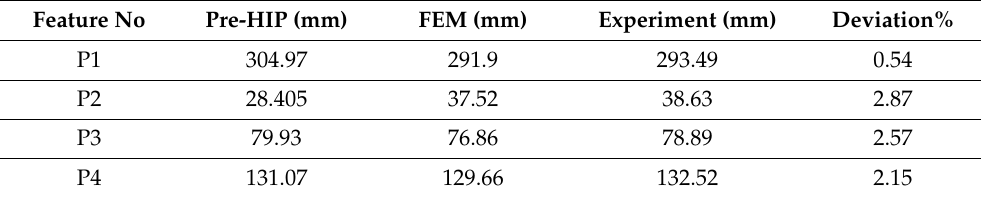
Figure 15. Experimental capsule post ‐ HIP (dots for 3D scanning) .